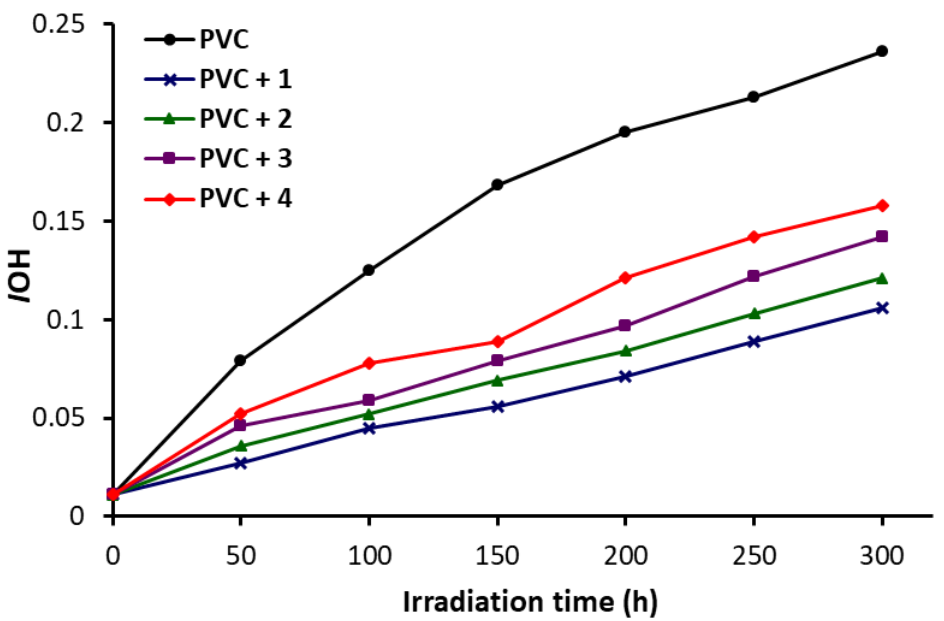
Figure 3. Effect of UV irradiation time on the I OH of PVC films.